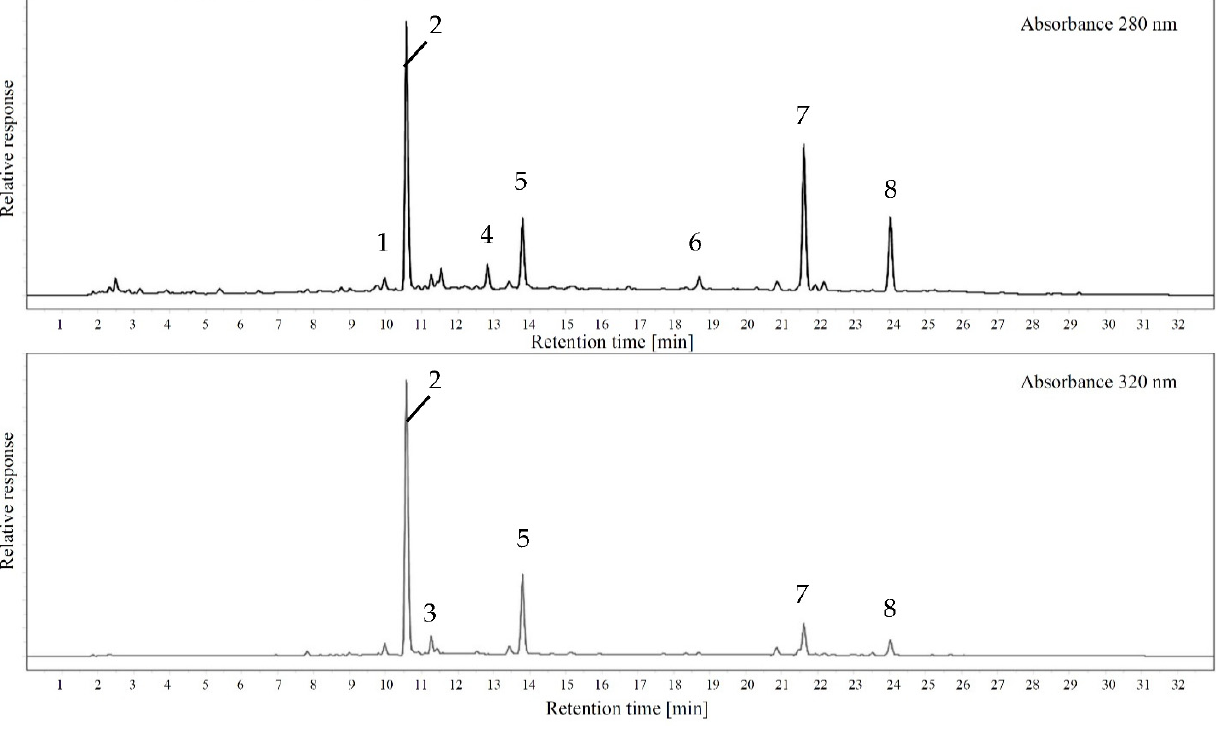
Figure 5. Example chromatogram of Geneva Crab cider analyzed at 280 nm and 320 nm (1: catechin; 2: chlorogenic acid; 3: caffeic acid; 4: epicatechin; 5: unknown p-coumaric acid derivative; 6: unknown procyanidin; 7: unknown caffeic acid derivative; 8: unknown procyanidin). Table 2. Quantitative data of monomeric phenolic compounds analyzed with LC-DAD at 280 nm and 320